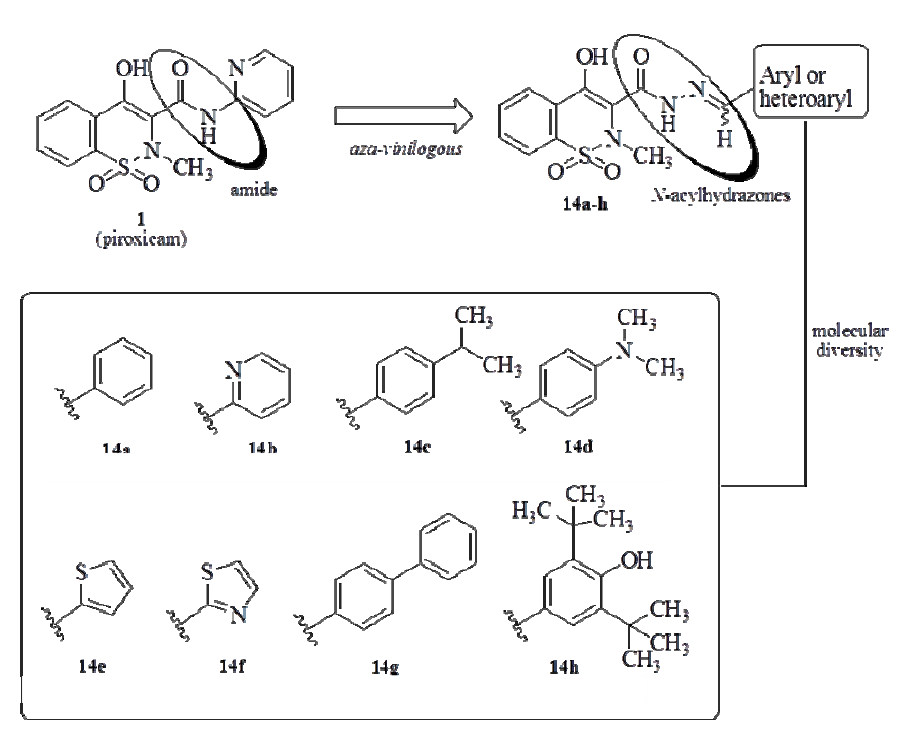
Figure 4. Design of a novel series of analgesic and anti-inflammatory benzothiazine N